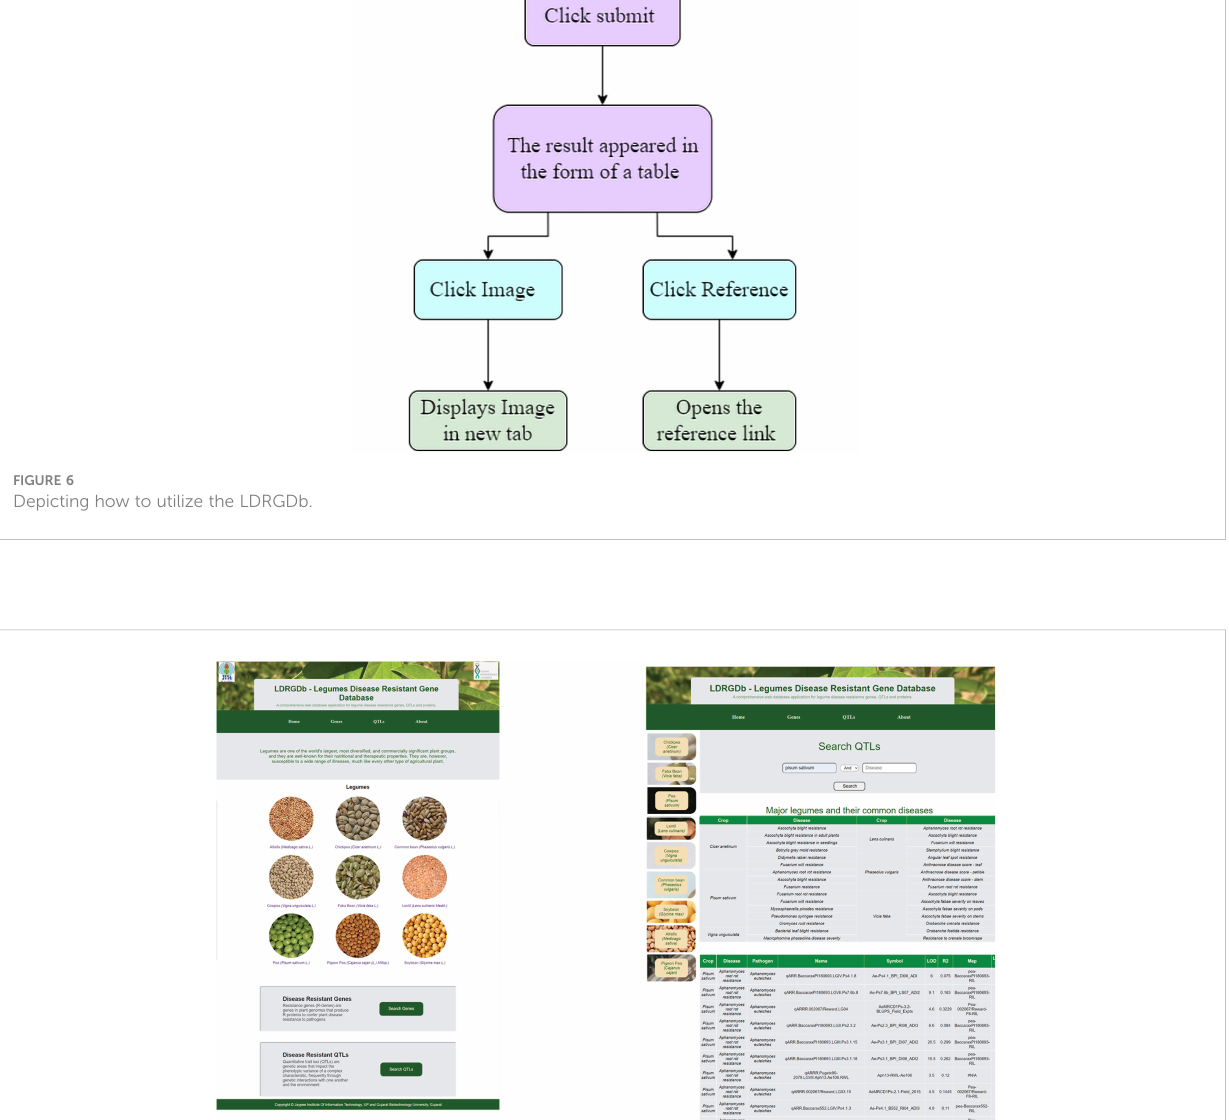
BA FIGURE 7 Images showing the (A) Front Page and (B) Search Page of the